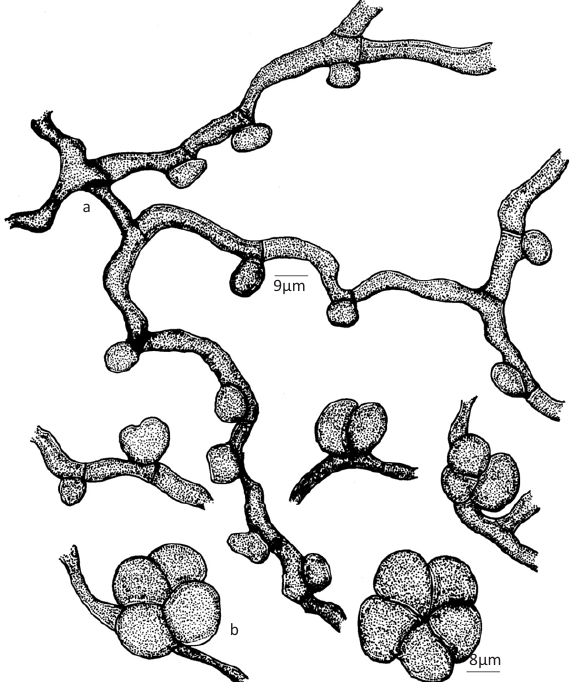
Figure 1. Sarcinella chloroxyli sp. nov. a - Appressoriate mycelium; b - Conidia